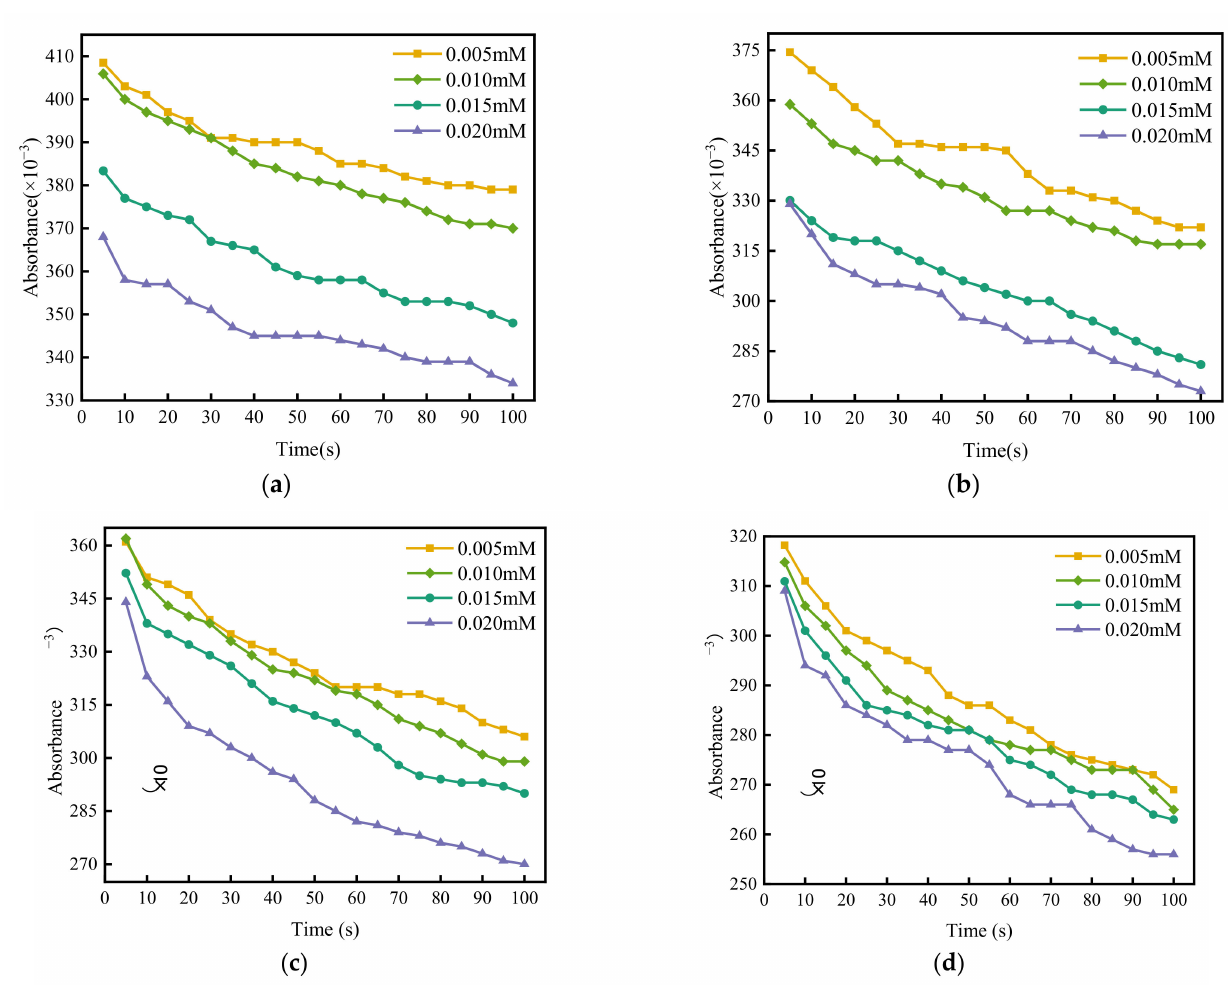
Figure 1. Effect of electrolyte concentration on absorbance. ( a ) MgCl 2 , ( b ) CaCl 2, ( c ) AlCl 3 , ( d ) FeCl 3